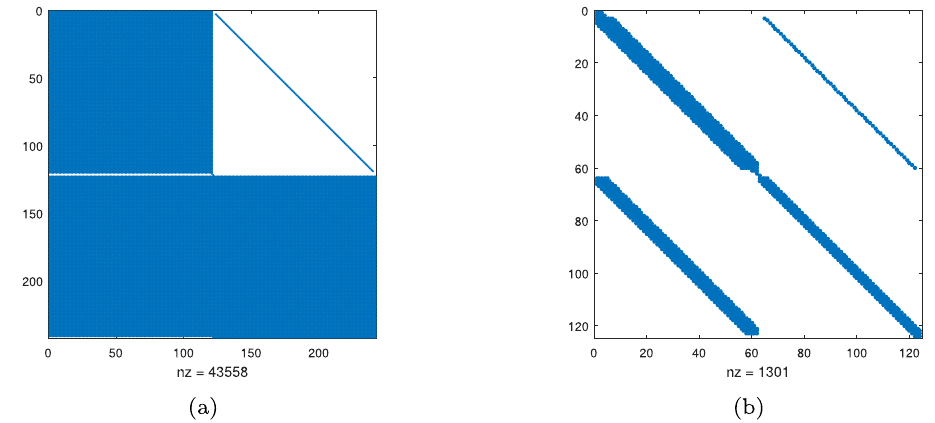
Figure 4: Sparseness arrangement of coe ffi cient matrix Δ for varying N η and (cid:2) . ( a ) Single - domain SQLM ( = = (cid:2) N 120, ) and ( b ) over -